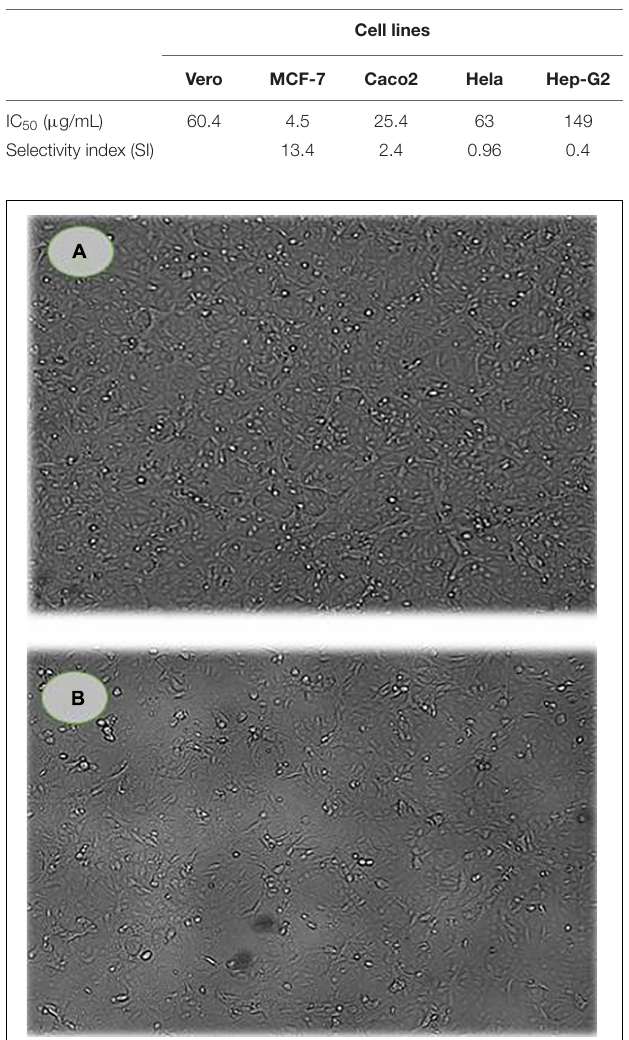
TABLE 4 | IC 50 values and selectivity index (SI) of PoPE treated normal and cancer cells.